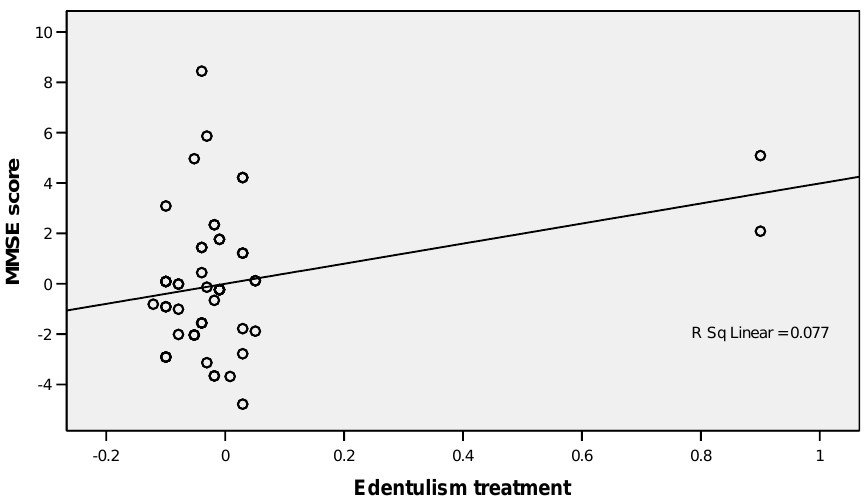
Figure 1. Linear regression plot showing a positive correlation between MMSE scores and edentulous treatments. Table 4. Linear regression analysis: association between MMSE score, sex, education, dentures, and subjective masticatory efficiency.